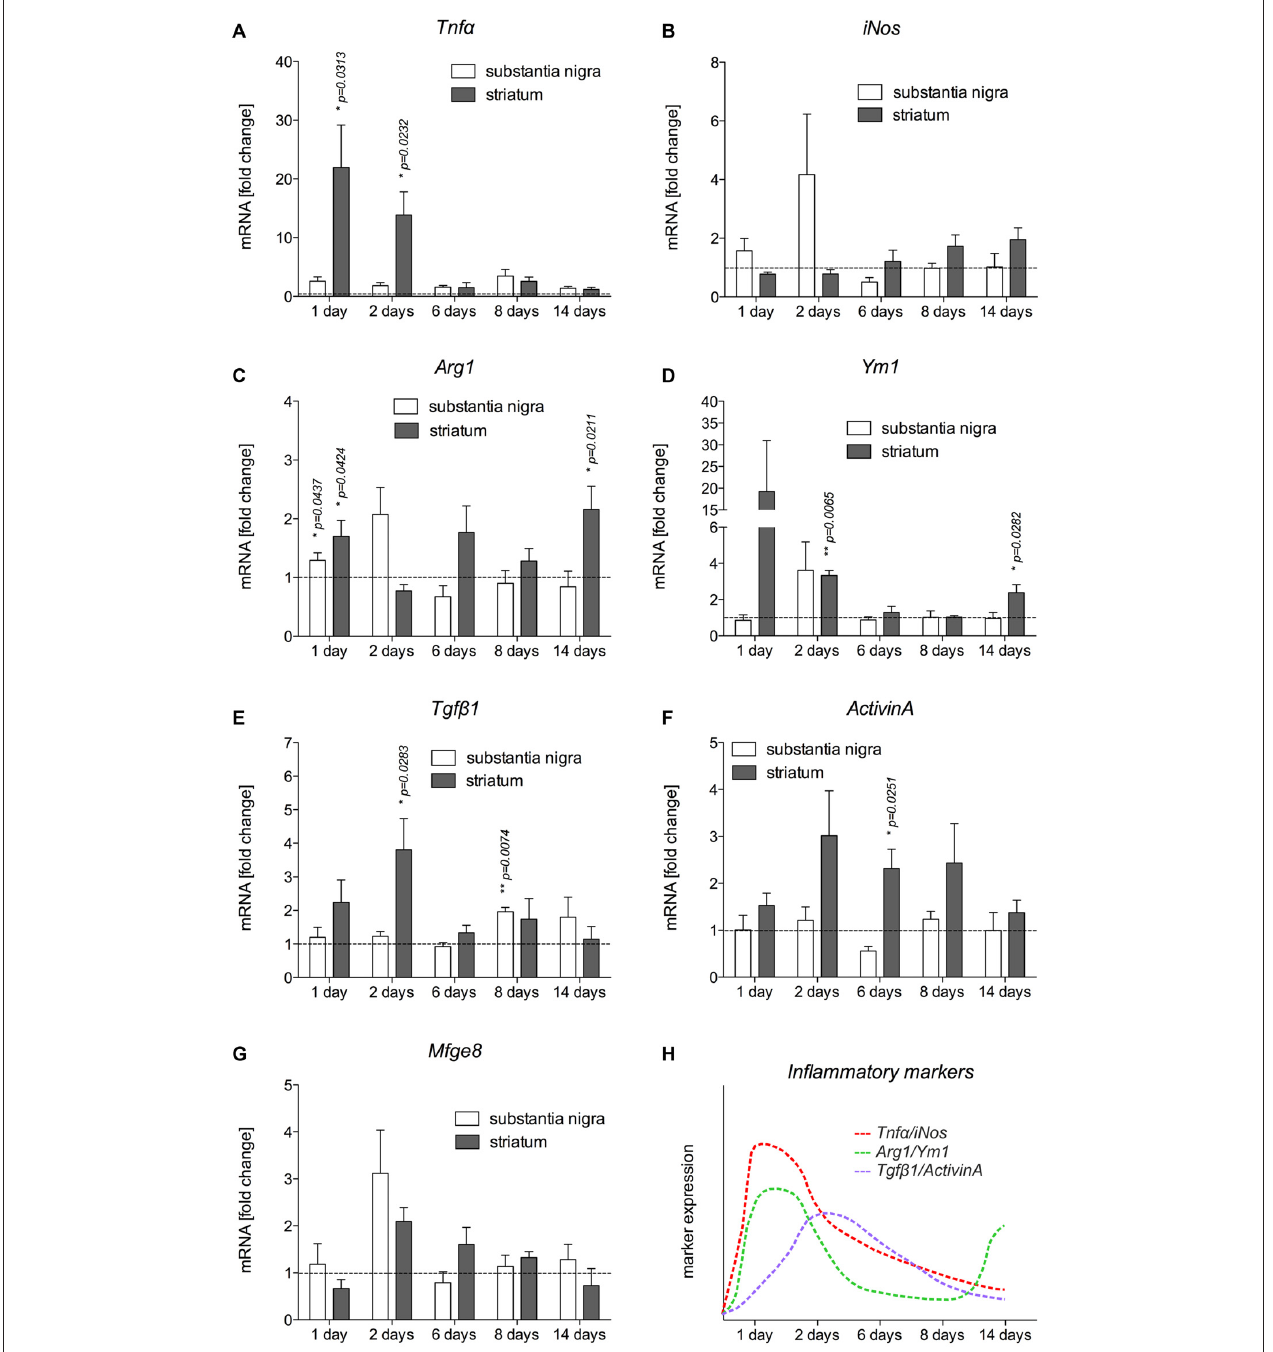
FIGURE 4 | Expression of inflammatory markers in SN and CPu after injection of 6-OHDA. The expression levels of the M1 activation markers Tnf α (A) and iNos (B) , the M2 activation markers Ym1 (C) and Arg1 (D) as well as TGF β 1 (E) and ActivinA (F) as anti-inflammatory factors as well as Mfge8 expression (G) as a TGF β 1-regulated gene have been analyzed and are displayed. Data are given as fold changes (mean ± SEM) calculated from expression levels on unlesioned control sides from at least three different animals. p -values derived from student’s t -test are ∗ p < 0.05 and ∗∗ p < 0.01. A summary of the temporal expression patterns of different markers is given (H)